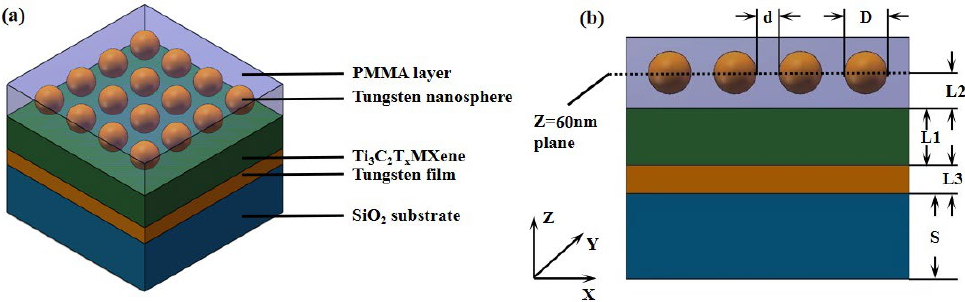
Figure 1. ( a ) Structure diagram of MXene/Wu-based absorber. ( b ) The cross-sectional view at the center of any row of nanospheres.